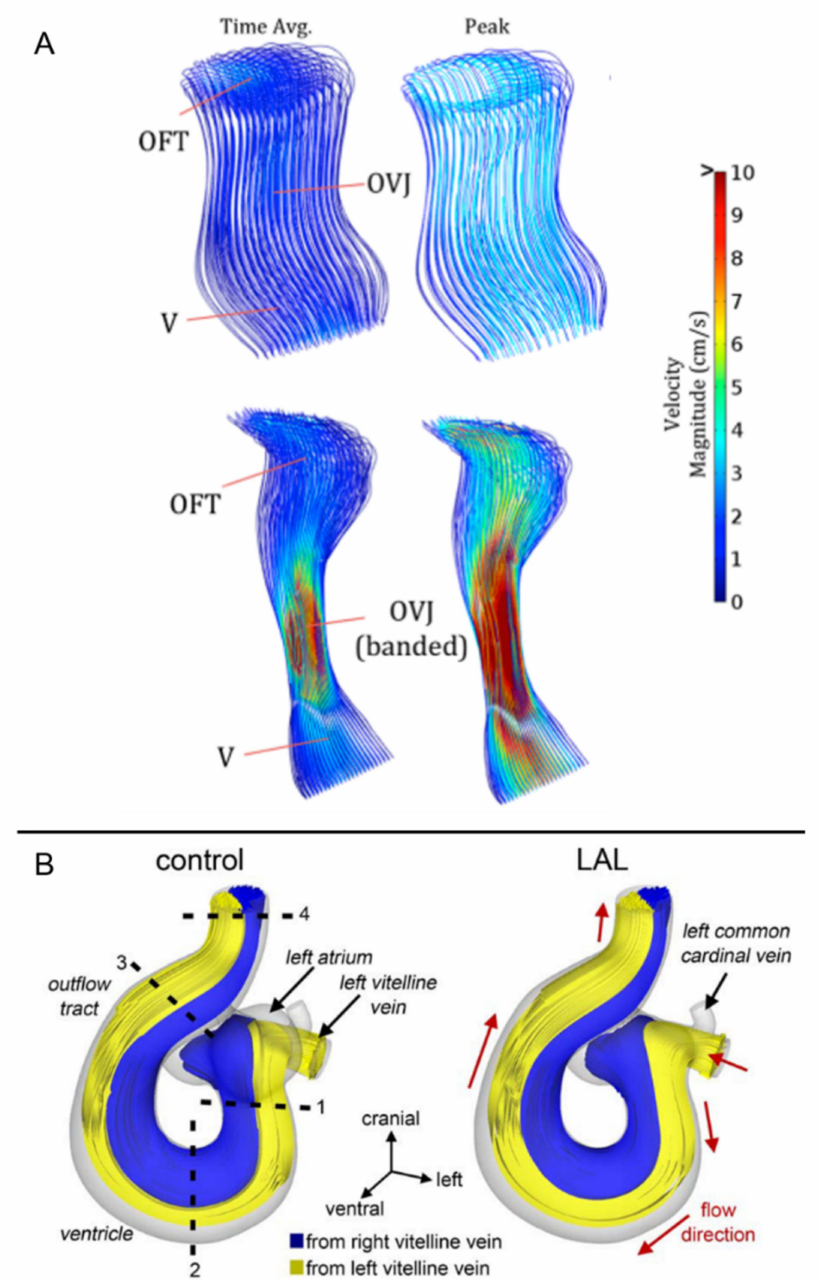
Figure 2. Blood flow velocity streamlines in normal and defected embryonic chicken hearts. ( A ) Peak and time-averaged velocity magnitudes on control (at top) and OFT banded (at bottom) chicken hearts at Hamburger–Hamilton stage 16–17 (HH16–17). V: ventricle, OVJ: OFT/ventricle junction (Reproduced from Menon et al. (2015) [111]). ( B ) Intracardiac flow patterns in normal and left atrial ligated (LAL) embryonic hearts at HH21. Blue and yellow streamlines represent the flows emanating from right vitelline vein (RVV) and left vitelline vein (LVV), respectively (Reproduced from Kowalski et al. (2014)